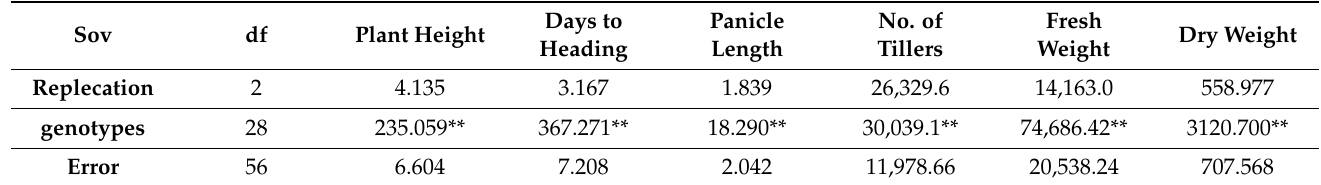
Table 3. Analysis of variance for the studied morphological traits.